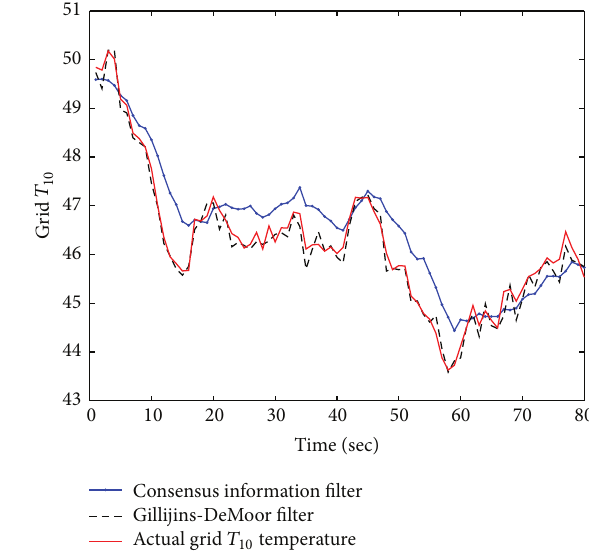
Figure 4: Temperature values of the rightmost grid.